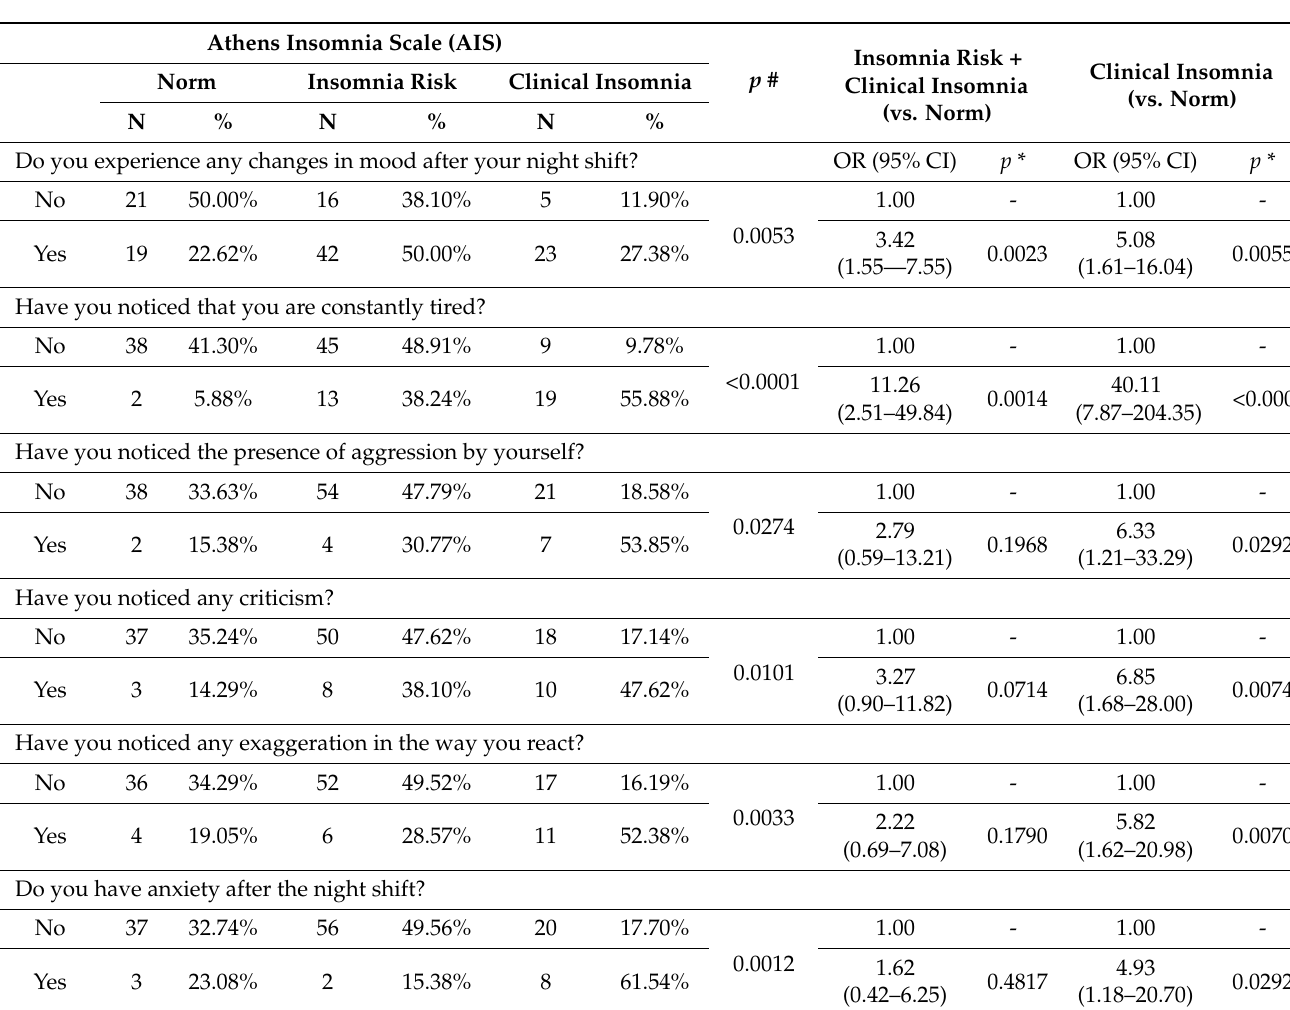
Table 7. The dependence of changes in behavior and the manner of responding respondents and the risk of sleep